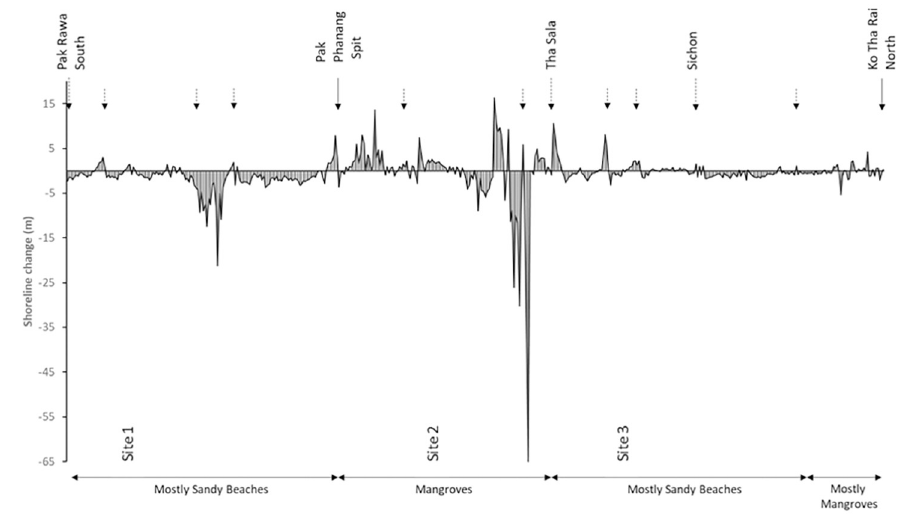
Fig 3. Shoreline change measured during the survey period along the Nakhon Si Thammarat coastline. The dashed arrows indicate the location of major river outlets. Plain arrows are used for geographic locations. The total length of coast is 236.8